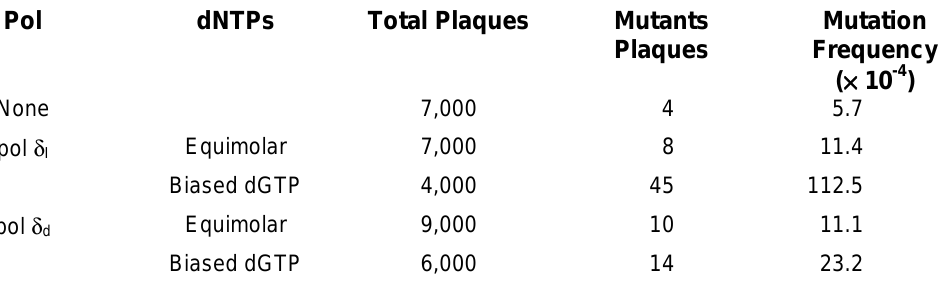
b Replication reactions were carried out for 2 h at 37ºC in 10 µ l containing: 50 mM Tris-HCl pH 7.5, 1 mM DTT, 100 µ g/ml BSA, 6 mM MgCl 2 , 50 ng of gapped circular M13mp2 DNA, 20 µ M each of dATP, dCTP, dGTP, and dTTP (equimolar) or additional 1 mM dGTP (biased dGTP), and pol δ i (0.064 units) or pol δ d (0.054